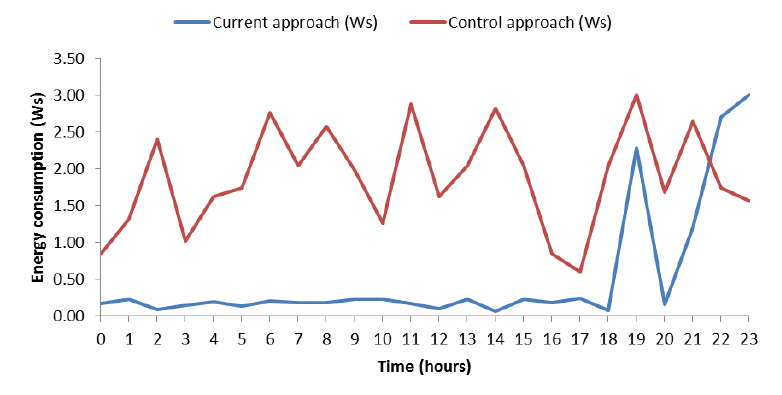
Figure 14. Energy consumption on 11 May.